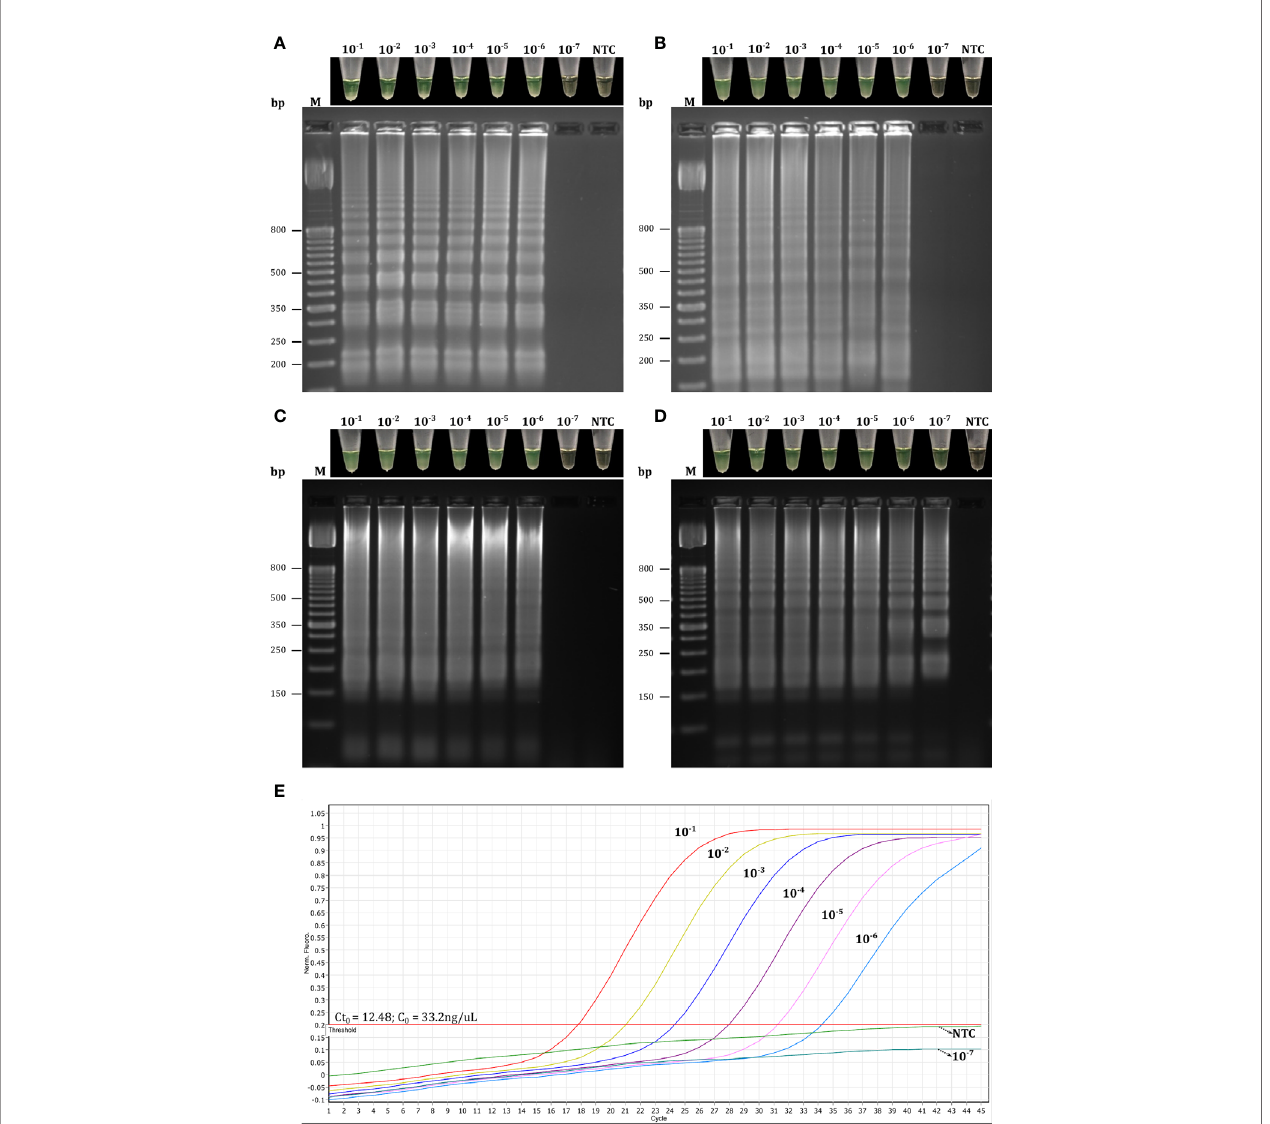
FIGURE 8 | Evaluation of combined LAMP primer sets based on target dilution. Reactions using the combined primer sets R34-R31 (A) , R18-R34 (B) , R18-8N3-R34 (C) , and R16.2-R34-R2 (D) were considered positive for RT-LAMP products if they had both a color change from brown to green and a laddered banding pattern on agarose gel after electrophoresis. Target dilution was based on log10 dilutions (10 -1 to 10 -7 ) of SARS-CoV-2 RNA obtained from clinical samples and the samples were analyzed in parallel by multiplex RT-LAMP (A – D) and RT-qPCR (E) assays. CT 0 , initial cycle threshold value of the clinical samples obtained by RT-qPCR; C 0 , initial concentration of the clinical samples; NTC, negative non-template control; bp, base